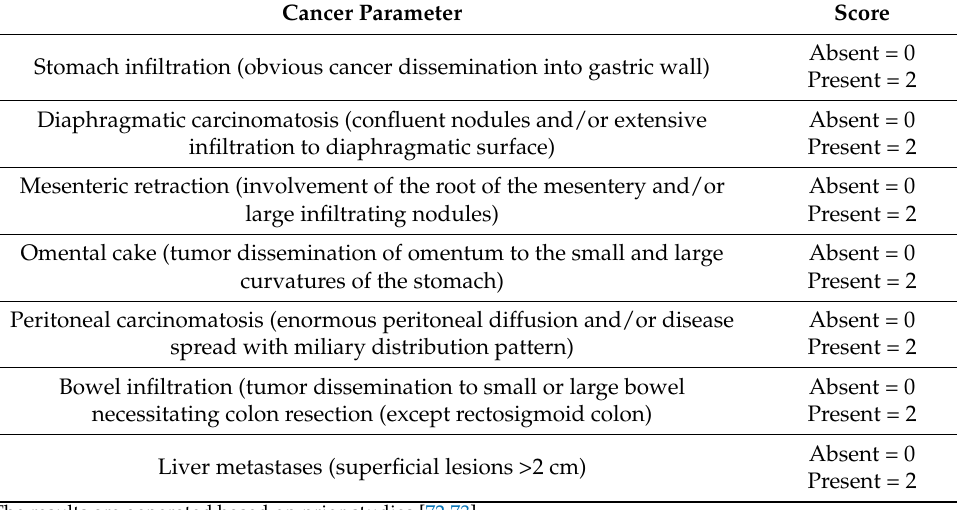
Absent = 0 Present = 2 Absent = 0 Present = 2 Absent = 0 Present = 2 Absent = 0 Present = 2